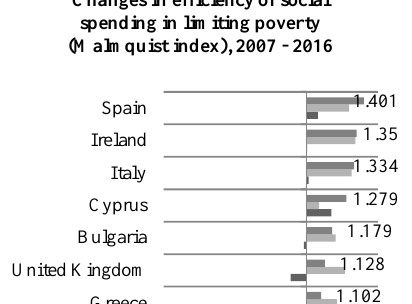
Figure 3. The Malmquist index and its decomposition for social efficiency of government spending in the EU